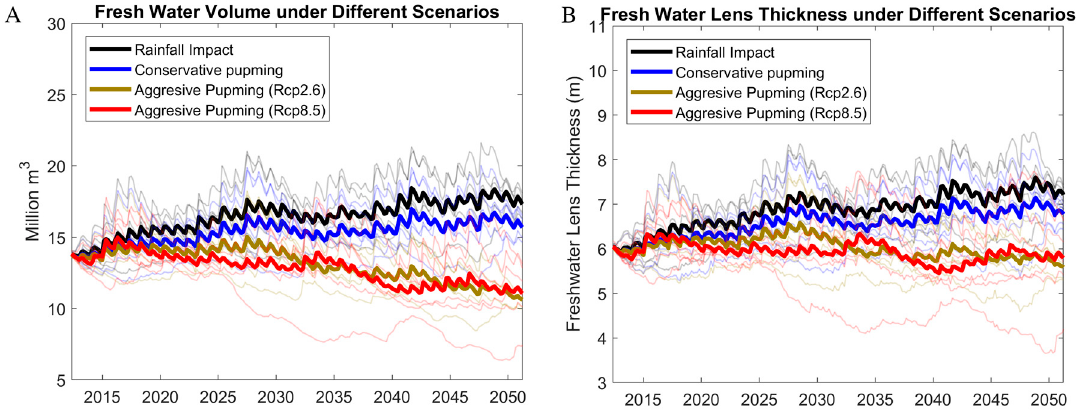
Figure 8. Time series charts showing the results of the modeling scenarios summarized as ( A ) freshwater lens volume and ( B ) freshwater lens thickness. Bold lines indicate averages from the set of GCM rainfall rates applied to each scenario, and the light lines show the results from the set of GCM rainfall rates applied to each scenario. The black line shows the impact of Scenario 1 (only future rainfall patterns); the blue line shows the impact of Scenario 4 (future rainfall + conservative pumping); the red and gold lines show the impact of Scenario 5 (future rainfall + aggressive pumping) for both the RCP2.6 and RCP8.5 climate scenarios.